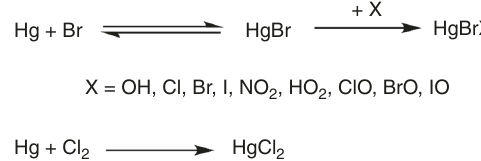
Fig. 1 Current understanding of the formation of oxidized Hg(II) compounds from atmospheric gaseous elemental mercury initiated by different oxidant species. This fi gure also includes other secondary oxidation mechanisms involving single-step reactions with Cl 2 , O 3 , BrO, and